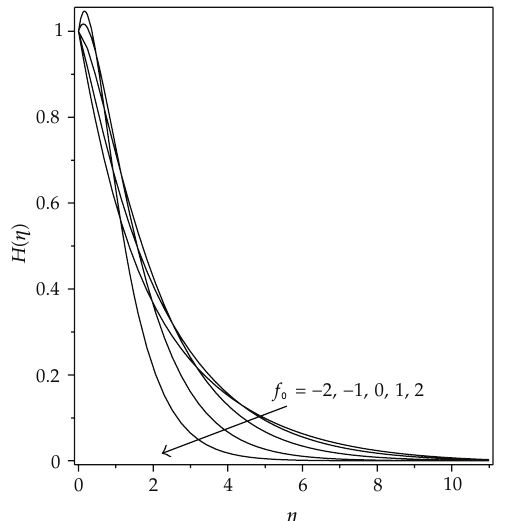
Figure 5: Concentration profiles for di ff erent values of f 0 when Pr (cid:9) 0 . 78, Sc (cid:9) 0 . 6, D f (cid:9) 0 . 03, S r (cid:9) 2, r (cid:9) 0, and M (cid:9) 0.